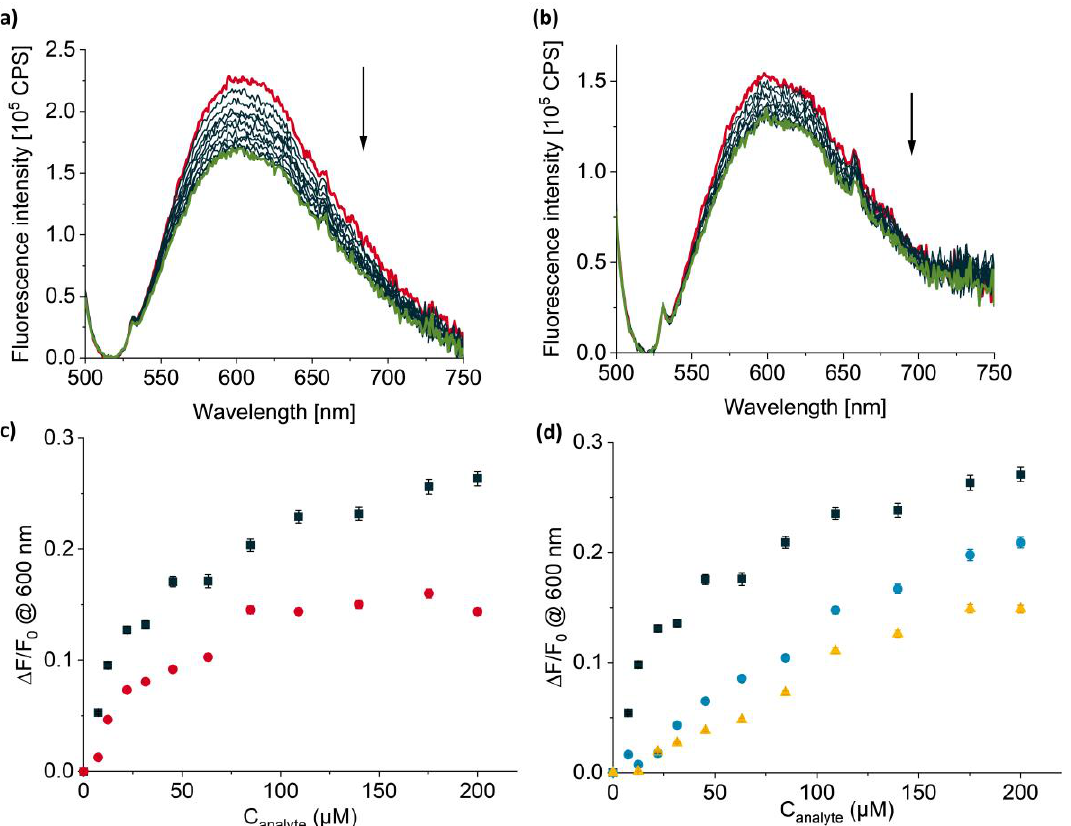
Figure 8. Fluorescence titration spectra of ( a ) MIPb@SiO 2 and ( b ) dNIPb@SiO 2 upon titration with ∆ F up to 200 µ M GPS-TBA in MeCN. ( c ) Relative fluorescence changes, , at 600 nm of MIPb@SiO 2 F 0 (black squares) and dNIPb@SiO 2 (red circles) upon titration with up to 200 µ M GPS-TBA in MeCN. ∆ F ( d ) Relative fluorescence changes, , at 600 nm of MIPb@SiO 2 upon titration with up to 200 µ M F 0 GPS-TBA (black squares), 2,4-D-TBA (blue circles) and dicamba-TBA (orange triangles) in MeCN. − 1 particle suspensions in MeCN were used in the Λ ex = 483 nm. Here, 2 mL of 1 mg mL